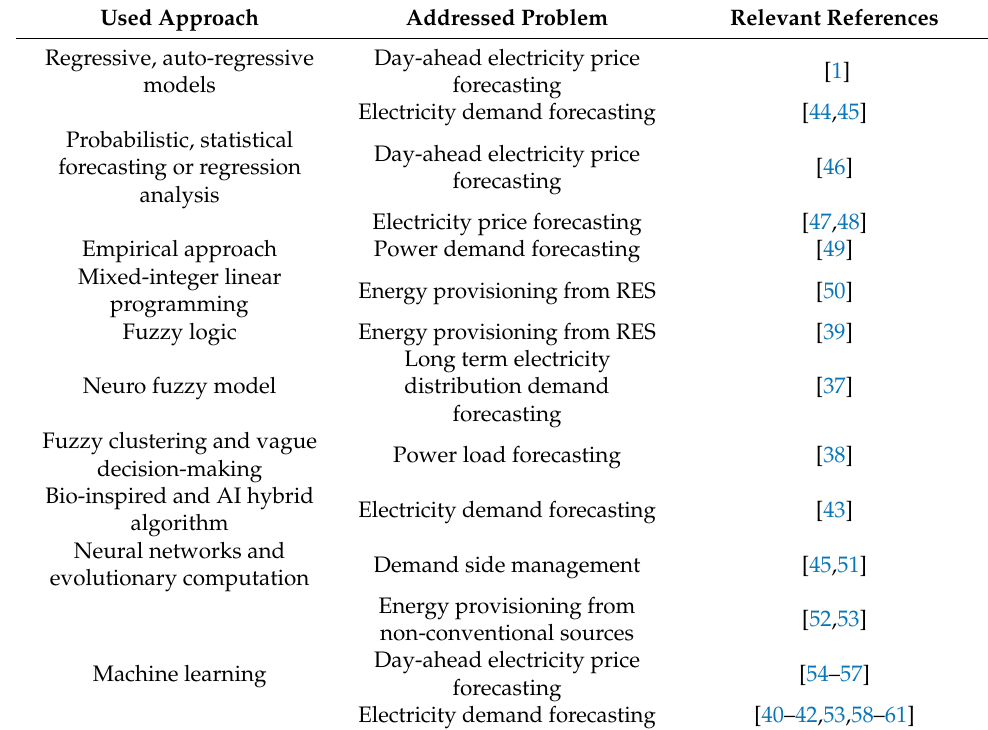
Table 1. Electricity forecasting selection and related